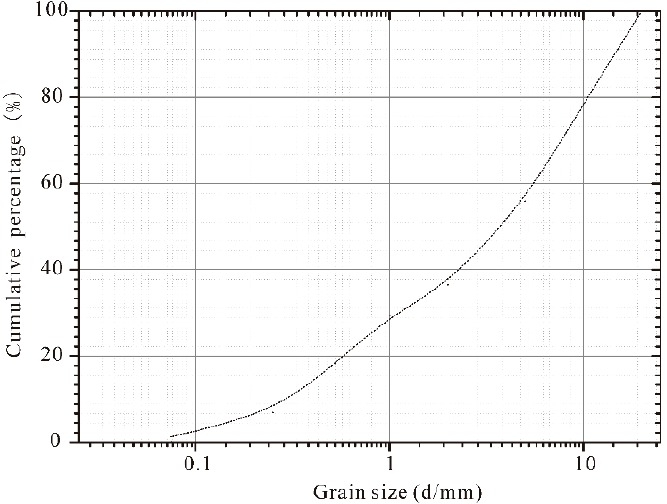
Figure 9. Grading curve of the debris flow deposits in Xiongmao Gully, for which the corresponding location is shown in Figure 2.